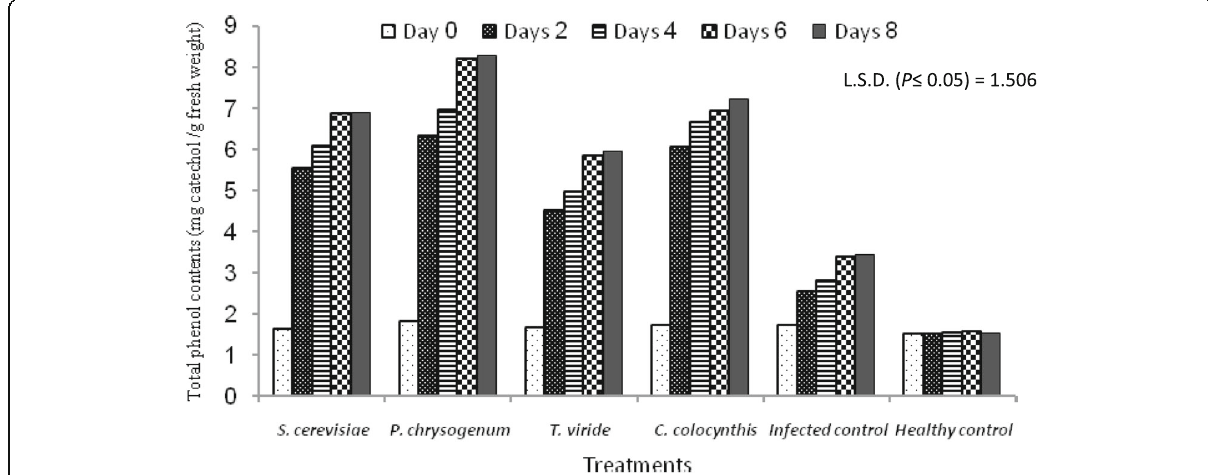
Fig. 2 Effect of application of bioagents and plant extract on total phenol contents (TPC) in onion